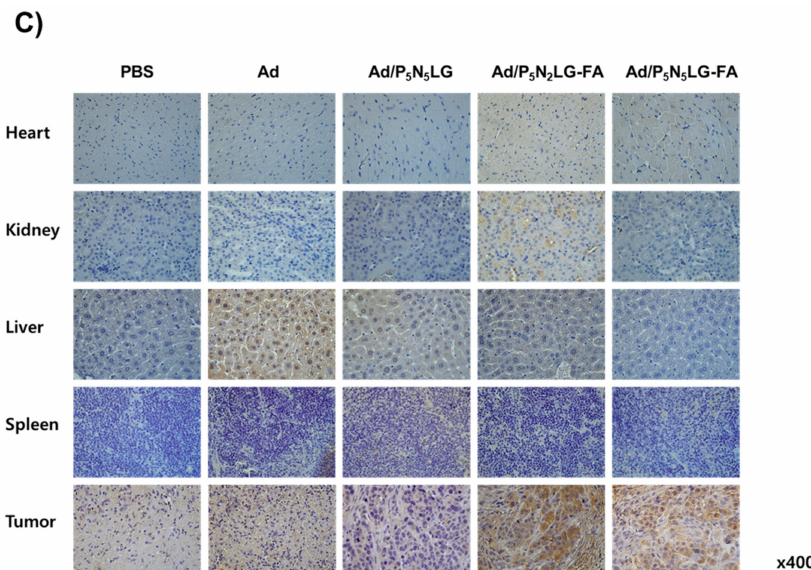
Figure 7. Pharmacokinetics and biodistribution profile of Ad nanocomplexes. ( A ) Pharmacokinetics of Ad nanocomplexes. Mice bearing subcutaneous KB tumors were intravenously administered once with 1 × 10 10 VP of naked Ad, Ad/P 5 N 5 LG, Ad/P 5 N 2 LG-FA, or Ad/P 5 N 5 LG-FA ( n = 3 per group). Blood samples were harvested from the retro-orbital plexus at 5 min, 10 min, 20 min, 30 min, 60 min, 1 h, 6 h, and 24 h after injection, then the genomic DNA were isolated. Ad genome copy number was determined by qPCR. Bars represent mean ± SD. *** p < 0.001 for Ad/P 5 N 5 LG, Ad/P 5 N 2 LG-FA, or Ad/P 5 N 5 LG-FA versus naked Ad at respective time points. ( B ) Biodistribution profiling of Ad nanocomplexes. Mice bearing subcutaneous KB tumors were intravenously injected three times with naked Ad, Ad/P 5 N 5 LG, Ad/P 5 N 2 LG-FA, or Ad/PN 5 LG-FA every other day ( n = 3 per group). At 24 h after the final injection, lung, heart, kidney, brain, muscle, spleen, liver, and tumor tissues were harvested. The genomic DNA was isolated from tissue samples, then Ad genome copy number was determined by qPCR. ( C ) Immunohistochemical analysis. Heart, kidney, liver, spleen, tumor tissues were collected at 2 days after the last treatment and stained with hexon Ab. Original magnification: × 400. Bars represent mean ± SD. * p < 0.05, *** p <